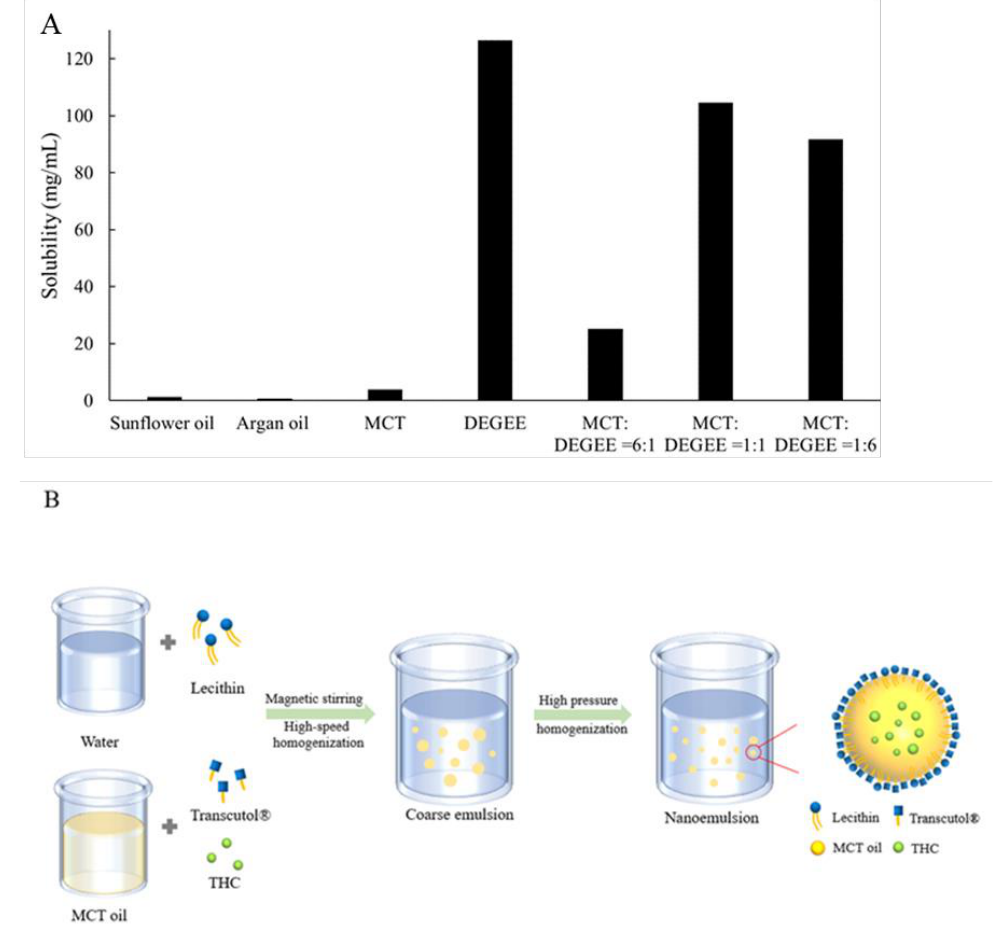
Figure 6. THC’s solubility in medium chain triglyceride (MCT), sunflower oil, argan oil, diethylene glycol monomethyl ether (DEGEE), or combination of MCT and DEGEE at various volumetric ratios (1:1, 1:6, 6:1) ( A ). Schematic illustration for preparing the lecithin based nanoemulsion ( B ).